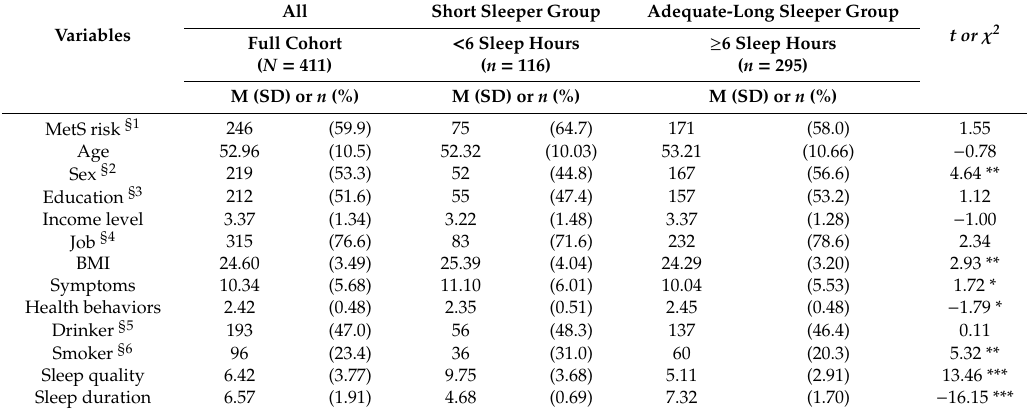
Table 1. General characteristics of study participants and comparisons of sleep duration subgroups.